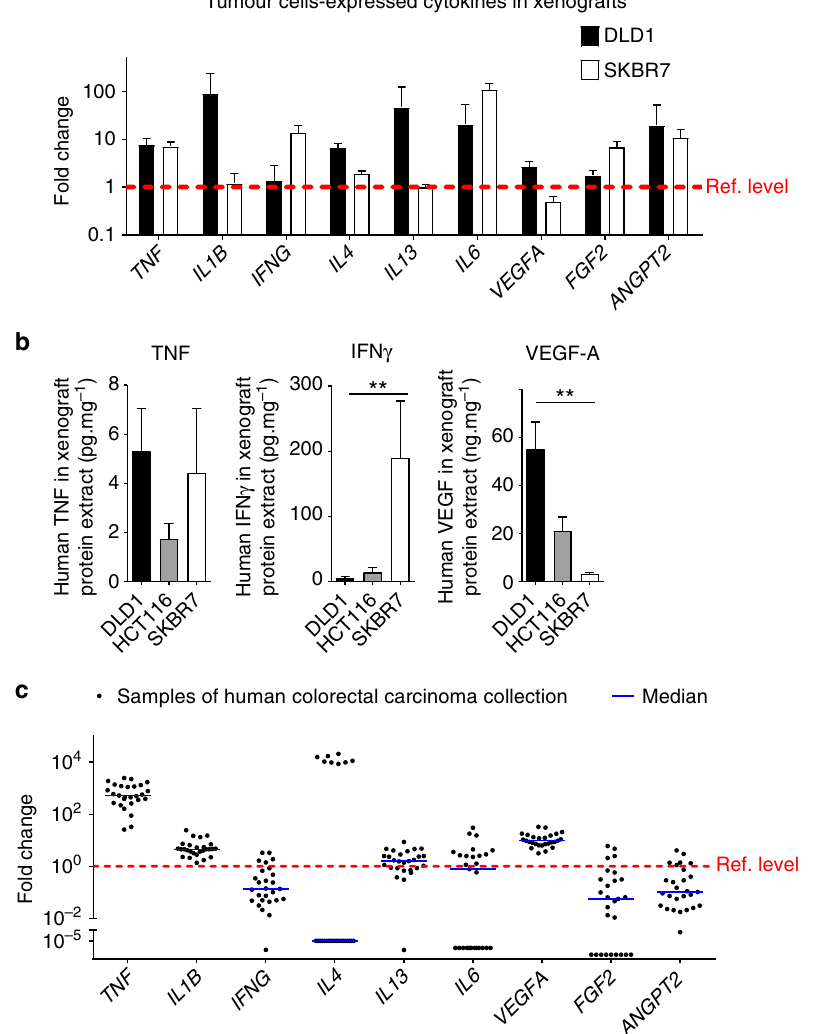
Fig. 2 Human tumours express a panel of cytokines and angiogenic factors. a Screening of human tumour cells-expressed cytokines (screened with human primers) in the xenografts ( n = 6 tumours per group pooled from two independent experiments). All molecule expression was normalised against the expression of housekeeping genes, namely GAPDH and ACTB . The expression levels of cytokines in DLD1 and SKBR7 xenografts are presented as relative (fold change) to their expression levels in HCT116 xenograft, which showed intermediate recruitment levels of proangiogenic monocytes. b Con fi rmation of cytokine expression level in tumour xenografts by ELISA. The protein levels of TNF, IFN γ and VEGF-A were quanti fi ed in protein extract of DLD1, HCT116 and SKBR7 xenografts ( n = 5 samples per tumour type) by ELISA. The data are presented as mean ± s.d., ** p -value < 0.005 in Kruskal – Wallis test. c Cytokine and angiogenic factor expression in samples of human colorectal carcinoma from the CREMEC tumour collection. The expression levels in samples ( n = 27 xenografts of independent human primary colorectal tumours from different individuals) are presented as relative (fold change) to their levels in HCT116 xenograft. The red dashed line indicates the reference stained respectively with green and blue cell tracker dyes (Fig. 3c). Confocal imaging con fi rmed that CD16 + monocytes remained on the luminal surface (apical), whereas in fl ammatory CD16 − monocytes populated the abluminal compartment of the endo- thelium (basal). To exclude effects of the labelling antibody on HPMo transmigration, pan-monocytes were pre-incubated with either PBS, control IgG or unlabelled anti-CD16 and the cell positioning after recruitment under fl ow was analyzed by con- focal microscopy. There was no adverse effect of the antibody on monocytes (Fig. 3d). In conclusion, stimulation of vascular endothelium with TNF, which was equally present in DLD1 and SKBR7 tumour xenografts, led to continuous crawling of HPMo and induced transmigration of in fl ammatory monocytes. Endo- thelial activation by in fl ammatory cytokines IL-1 β , IL-4 or IL-13,